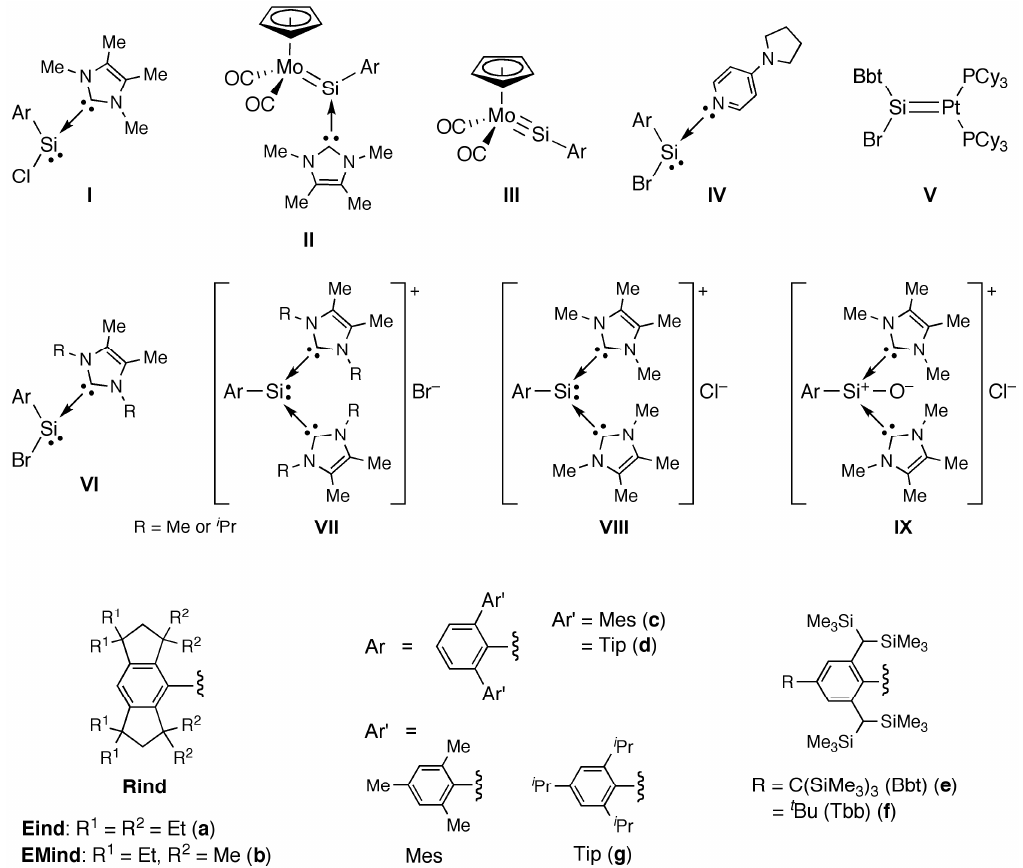
Figure 1. Examples of coordination-stabilized arylhalosilylenes and their derivatives. Each one of the possible canonical forms is depicted.